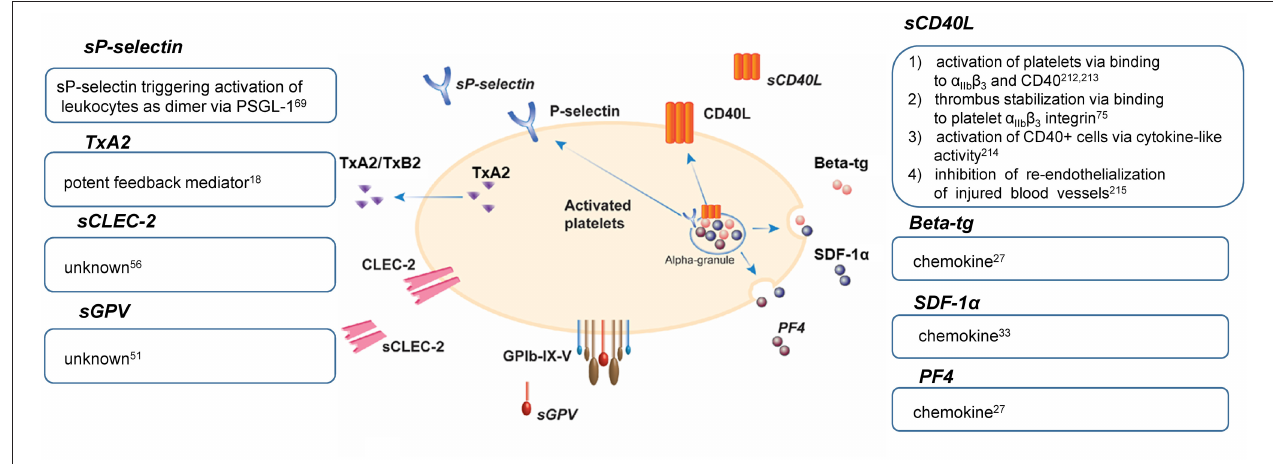
FIGURE 1 | Physiological functions of platelet release factors (77–80). beta-tg, β -thromboglobulin; CD40L, CD40 ligand; CLEC-2, C-type lectin-like receptor 2; GP, glycoprotein; PF4, platelet factor 4; PSGL-1, P-selectin glycoprotein ligand-1; SDF-1 α , stromal cell-derived factor-1 α ; TxA2, thromboxane A2; TxB2, thromboxane B2; s,